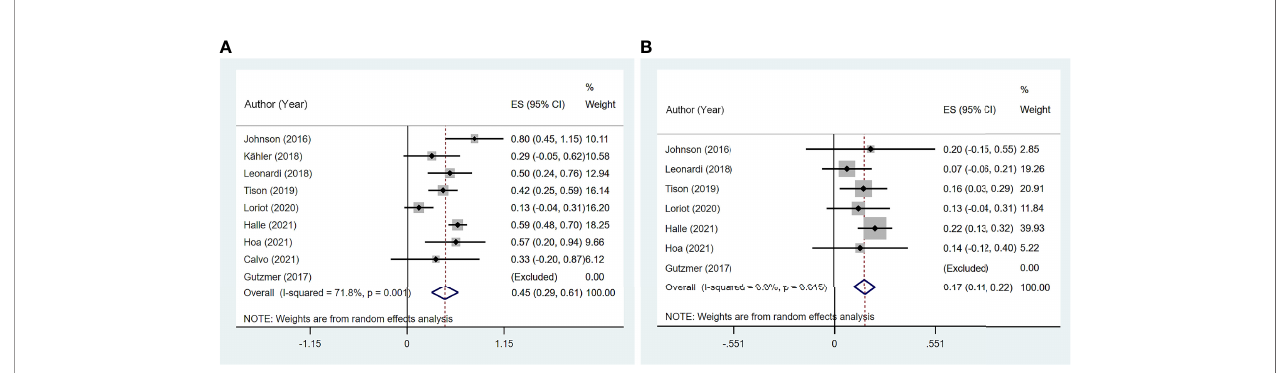
FIGURE 4 | The pooled incidence of de novo immune-related adverse event (irAE) in patients with cancer and preexisting psoriasis. (A) The incidence of fl are for any grades. (B) The incidence of de novo irAE for grades 3